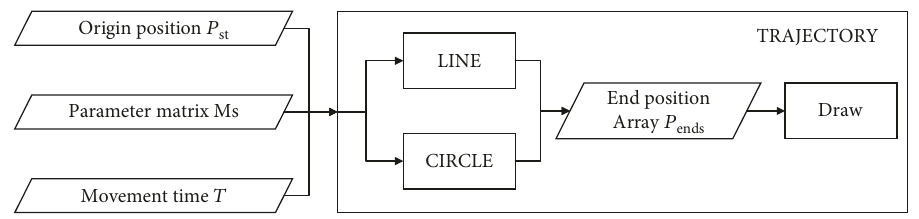
Figure 7: Program modules with internal